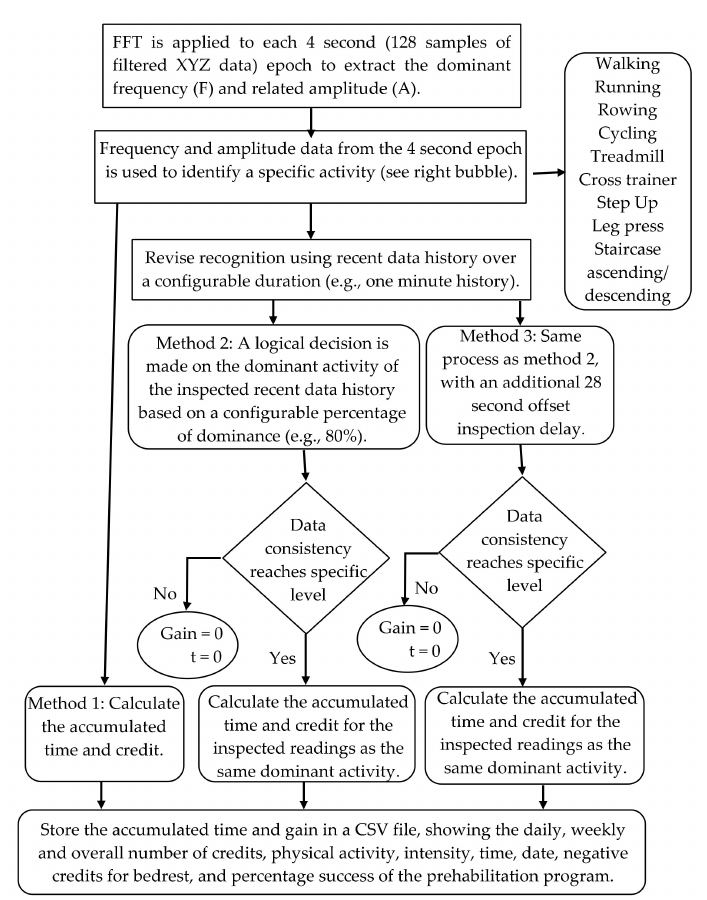
Figure 1. The flow chart of the three methods of activity recognition.